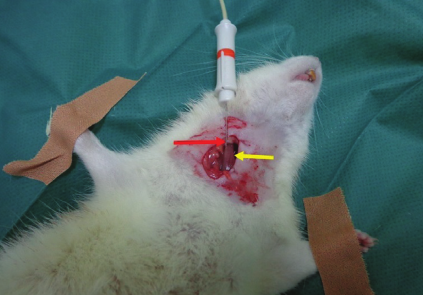
Figure 2: Recording electrode (red arrow) inserted into right cleidomastoid portion of sternocleidomastoid muscle (yellow arrow).